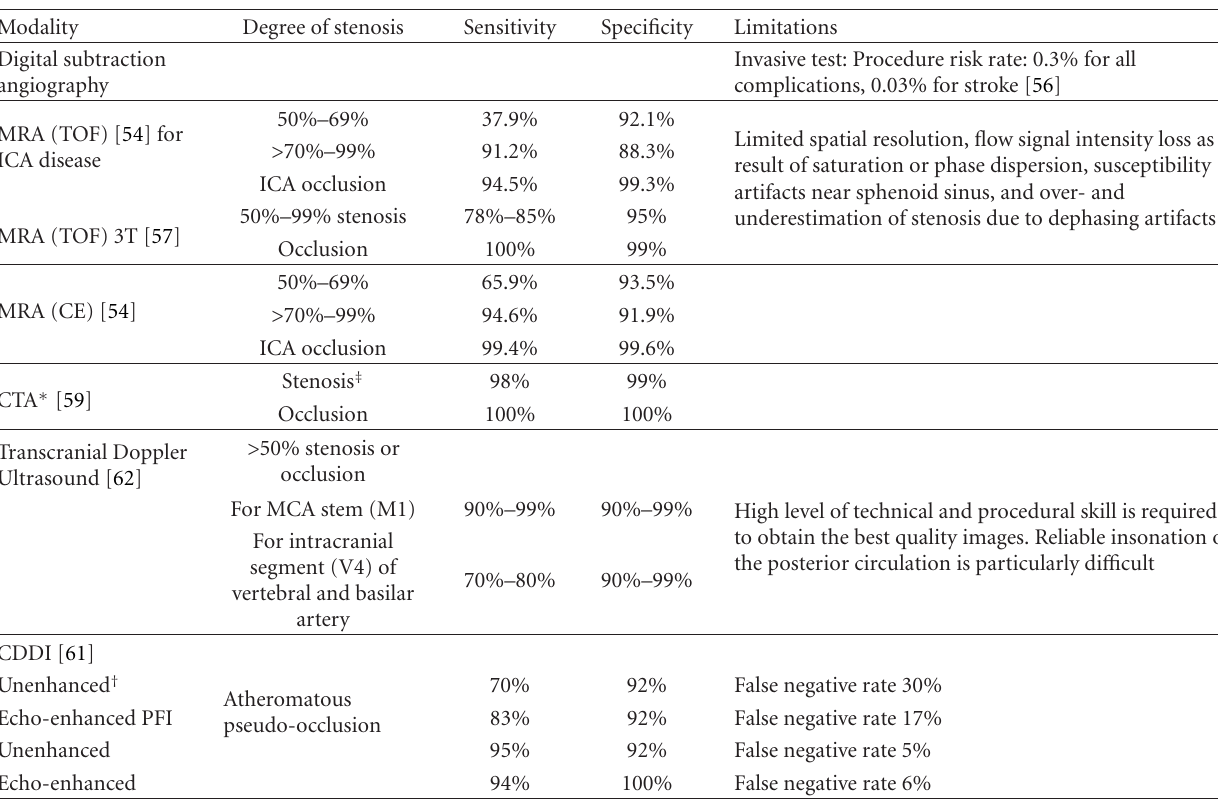
Table 2: Comparison of nonimaging modalities in the detection of intracranial